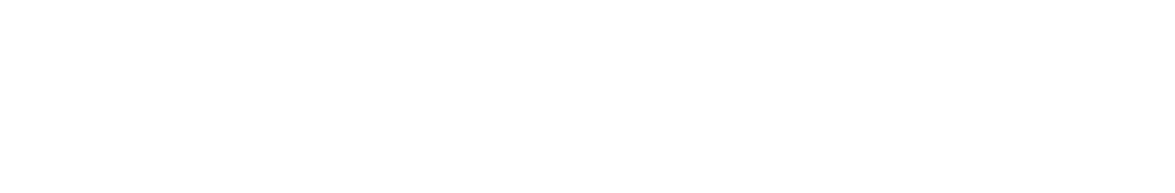
PLOS ONE | https://doi.org/10.1371/journal.pone.0274699 October 19,